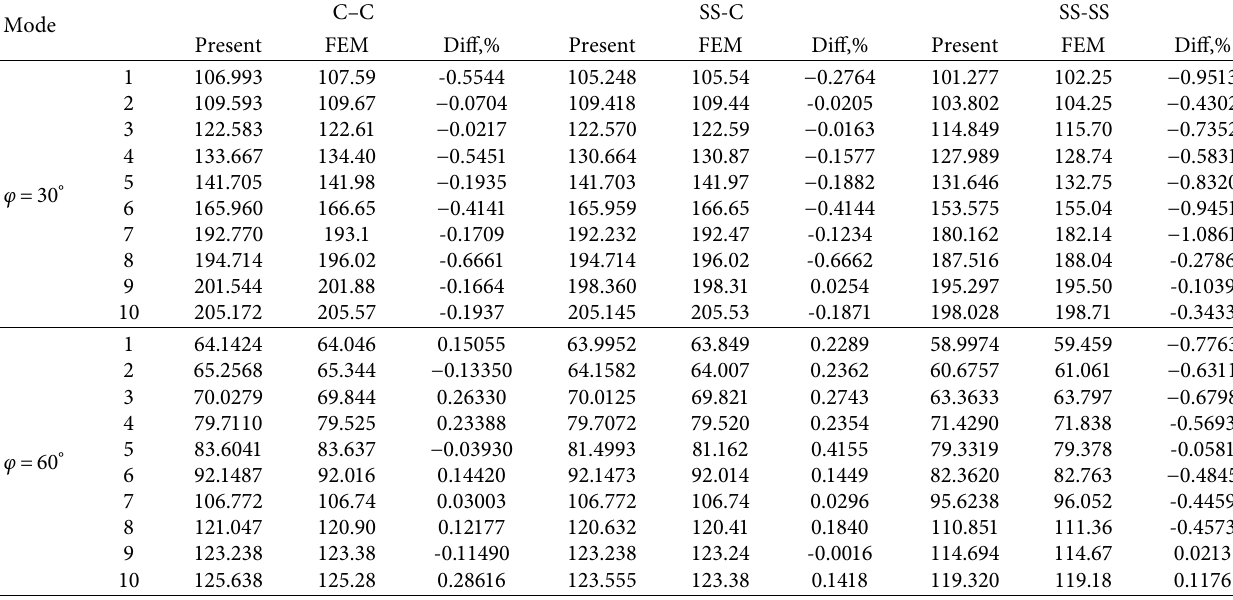
Table 6: Comparison of the first ten natural frequencies for laminated composite conical shell with variable thickness and semivertex angles. C–C Mode